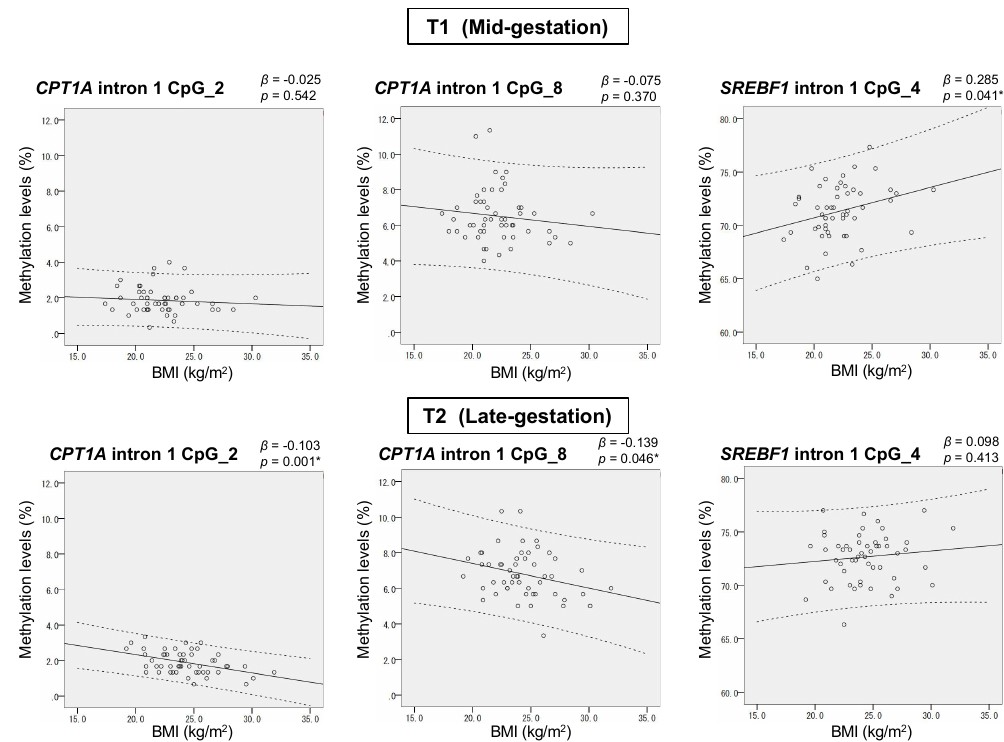
Figure 2. Scatter plots showing the relation between BMI and the methylation levels of adiposity-related methylation sites at two time points during pregnancy. Solid line, a regression line; dotted line, 95% confidence intervals. The scale is adjusted to the methylation for each CpG site. β (regression coefficient) stands for the % change in methylation per unit increase (1 kg/m 2 ) in BMI.